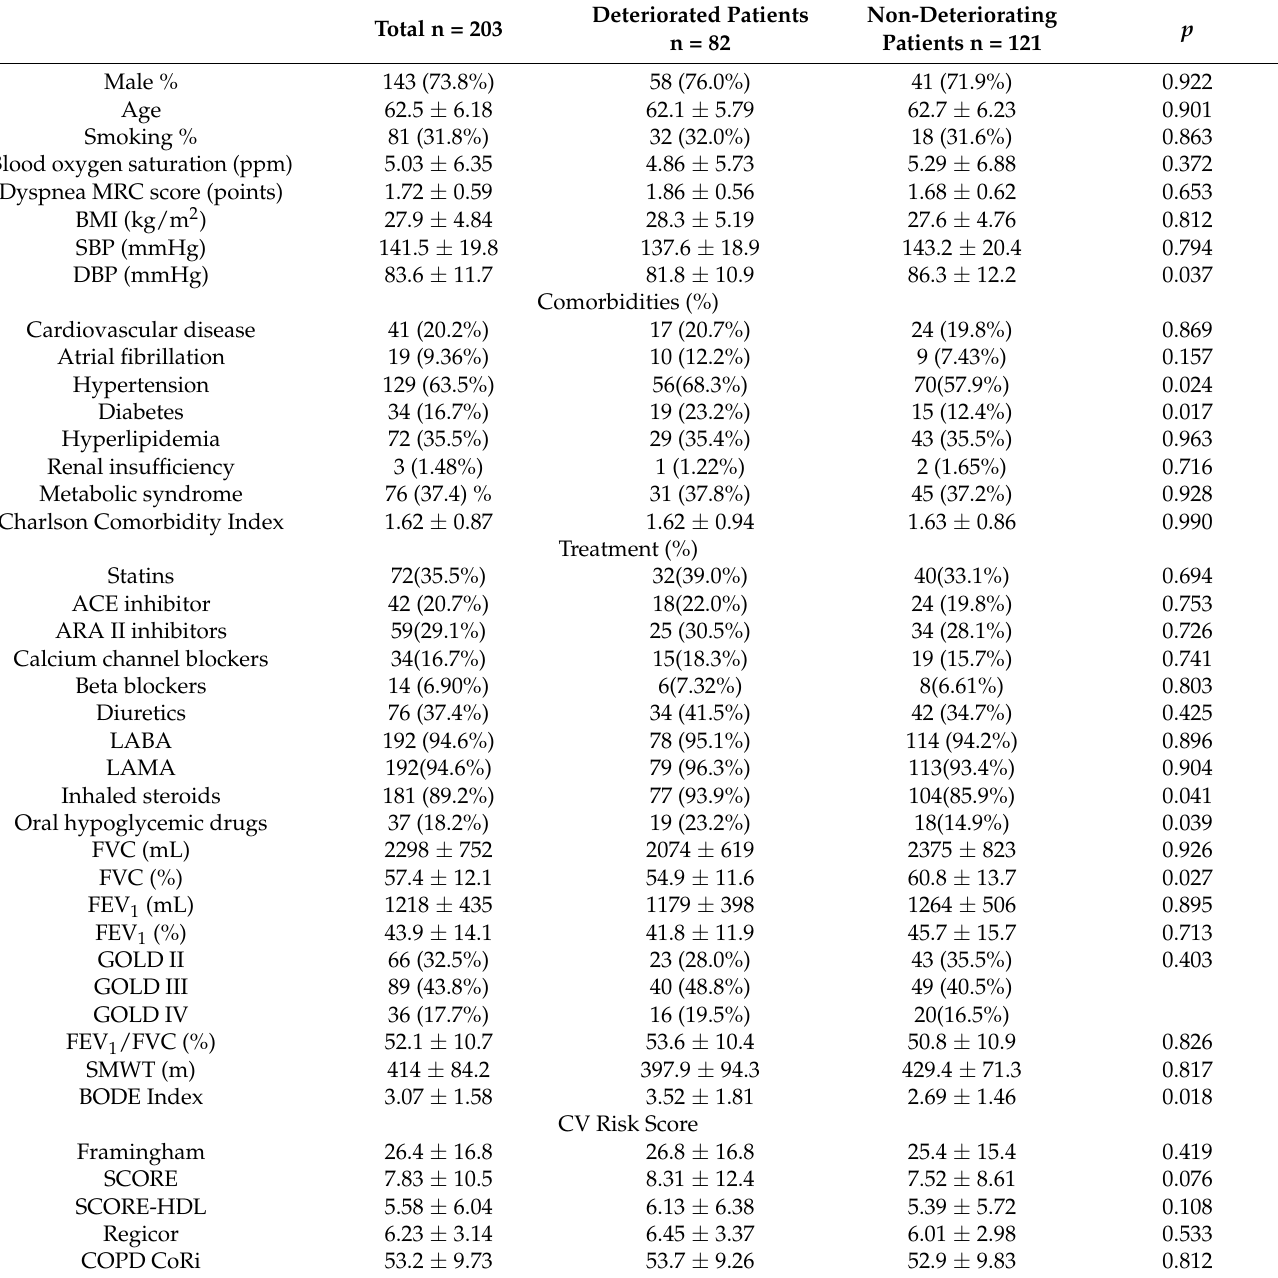
Table 1. General data of the two groups of patients. Deteriorated Patients Total n = 203 n =